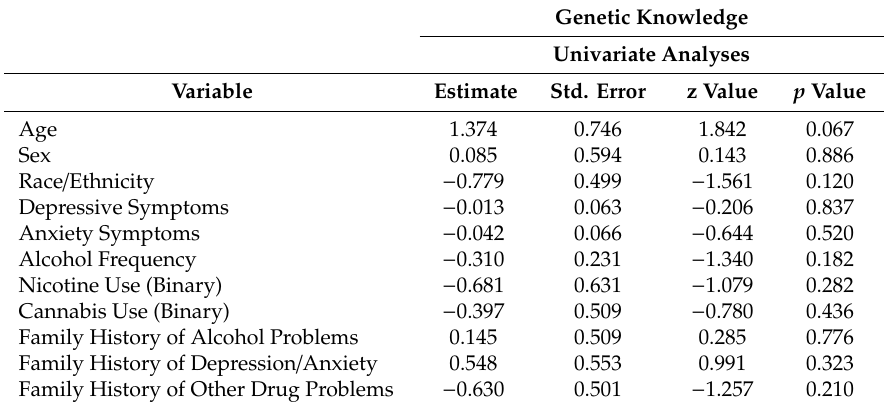
Table 7. Results from the univariate regression analyses assessing associations between demographic characteristics, substance use and mental health variables, and family history and overall genetic